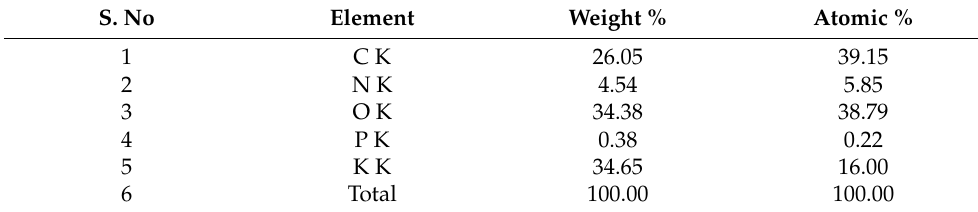
Table 3. Chemical composition of KPC heterogenous